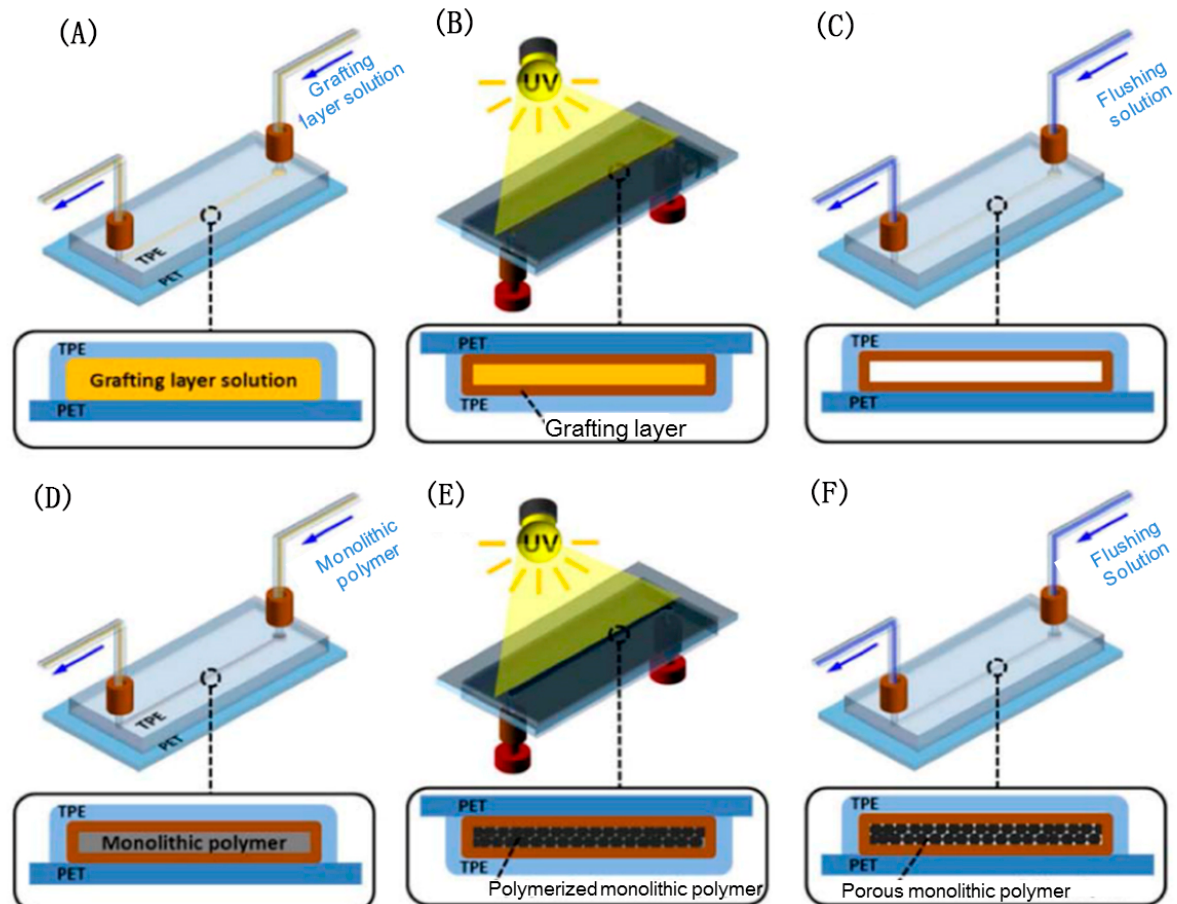
Figure 5. Schematic representation of the fabrication process of monolithic on-chip liquid chromatography. ( A ) Flushing of the grafting layer solution into micro channel; ( B ) UV light initialized polymerization to prepare grafting layer; ( C ) Cleaning of the grafting layer by water/methanol solution; ( D , E ) Fabrication of nano-porous monolithic polymer by UV initialized polymerization; ( F ) Cleaning of the reagent residuals. Reprinted with permission from Kim et al. [42]. Copyright 2018 Springer, 2018.